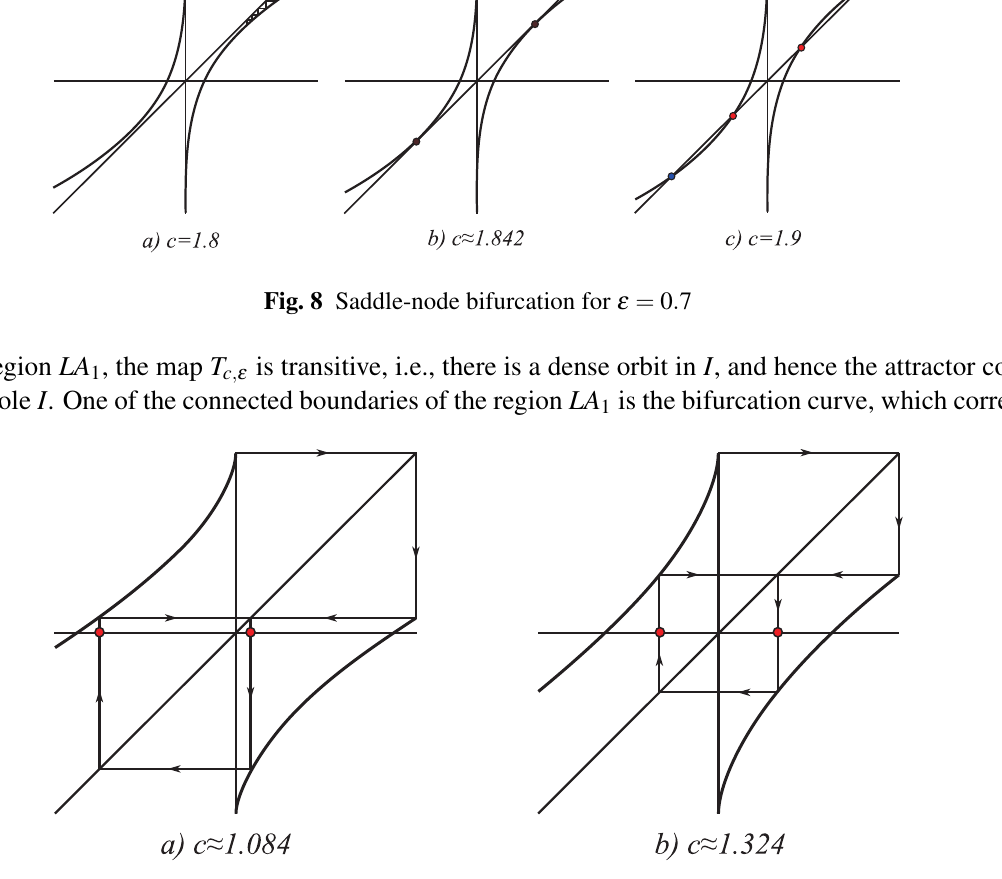
Fig. 9 Trajectory of the discontinuity point at the boundary of the LA 2 region for ε = 0 .